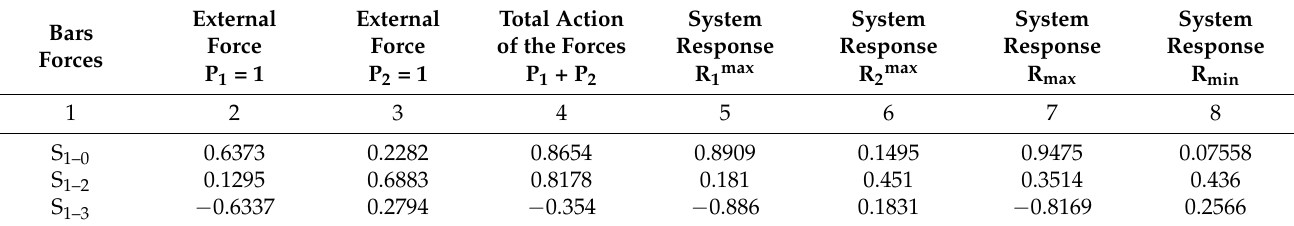
Table 1. Internal forces in the rods of the system from the nodal external and reactive